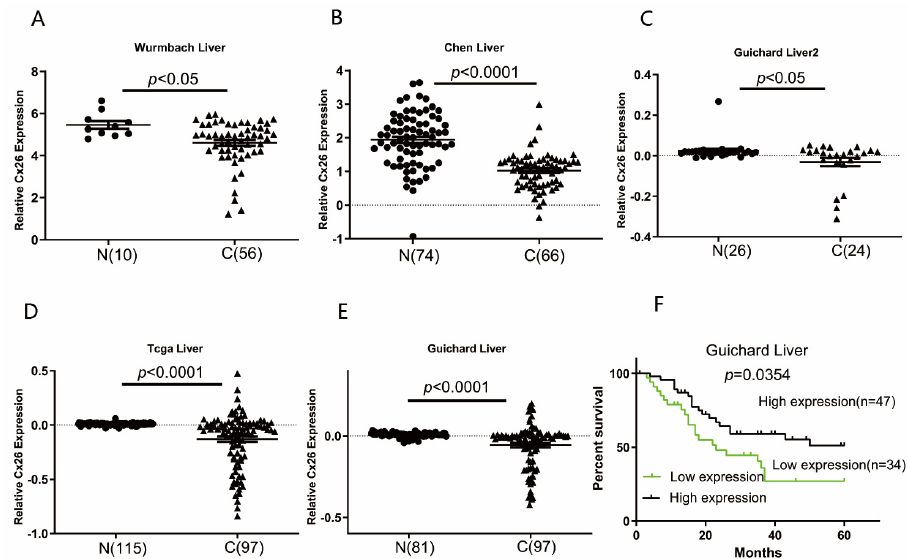
Figure 1. ( A – E ) The Cx26 expression levels in liver cancer tissues and normal liver tissue samples were compared using the Oncomine TM database (http://www.oncomine.org/, accessed on 15 September 2019), with 340 samples of liver cancer tissue and 306 normal liver tissue samples. N represents normal liver tissue samples; C represents liver cancer tissue samples. ( F ) The survival data of Guichard